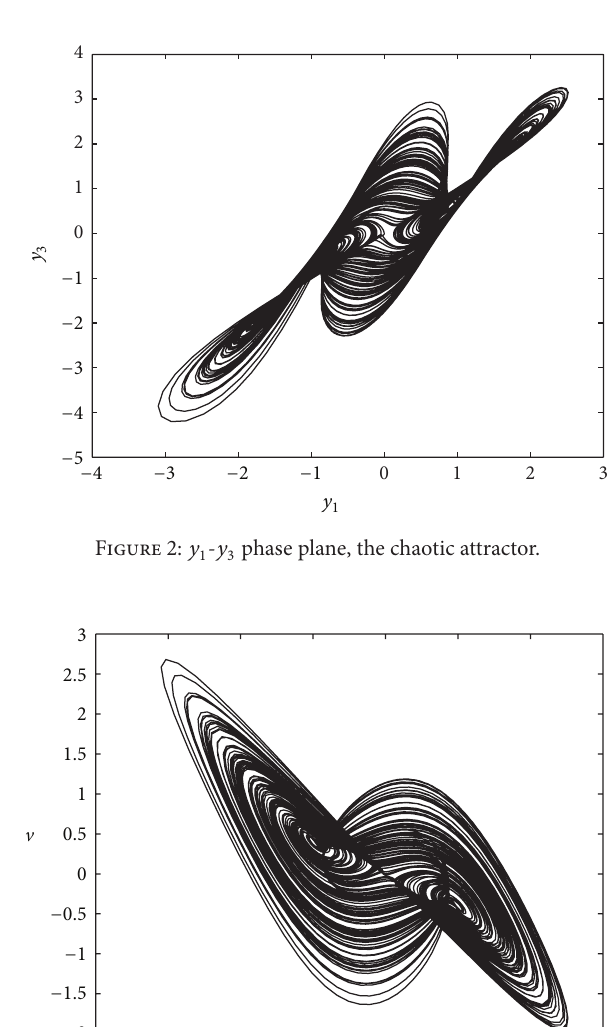
Figure 1: 𝑦 1 - 𝑦 2 phase plane, the chaotic attractor.